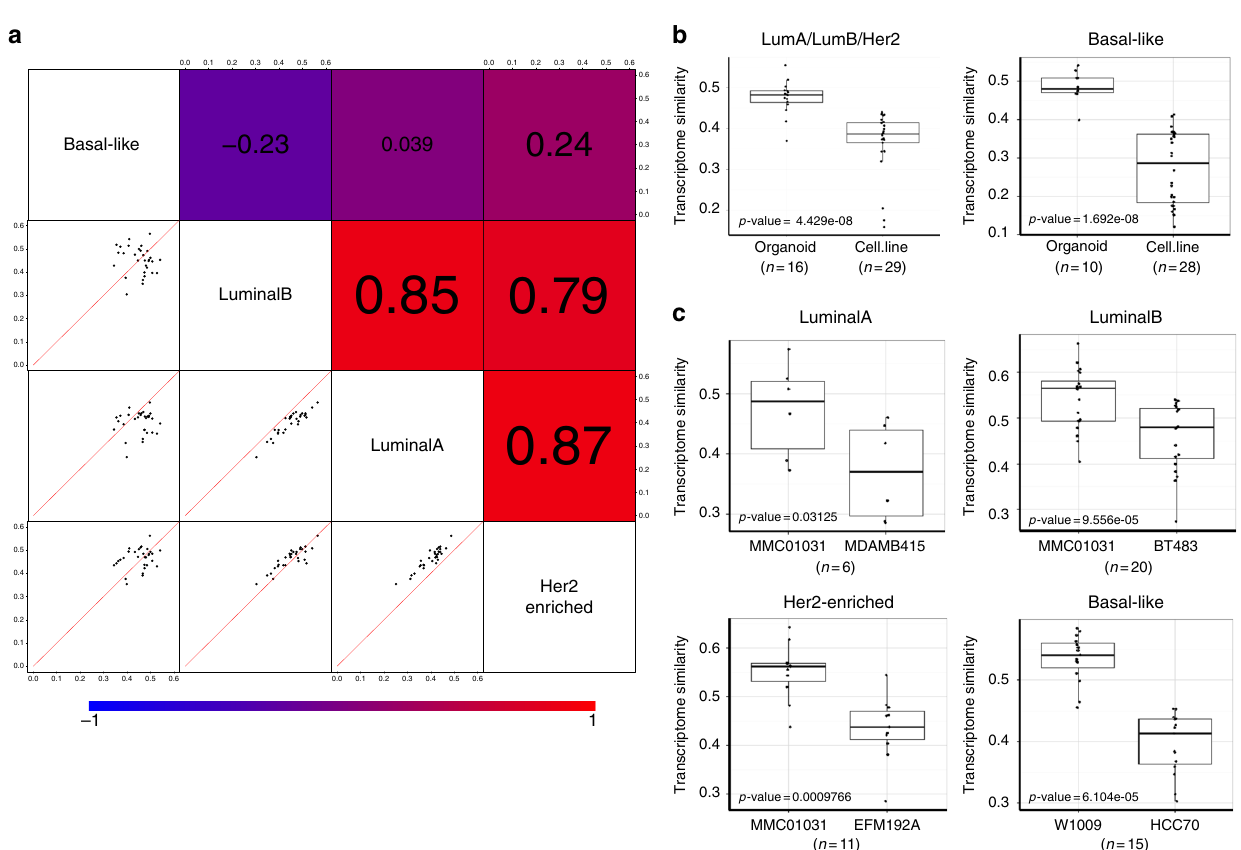
Fig. 5 Comparing CCLE breast cancer cell lines with patient-derived organoids using gene expression data. a Pair-wise comparison of subtype-speci fi c TC analysis results. In the lower-left plots, each dot is an established organoid, with the two axis representing transcriptome similarity of the organoid with MET500 breast cancer samples of the two intersecting subtypes. The upper-right shaded values are the corresponding pair-wise spearman rank correlation values of each pair. b Boxplot of transcriptome similarity (with MET500 breast cancer samples of different subtypes) of CCLE breast cancer cell lines and organoids. P -values are computed with the two-sided Wilcoxon rank-sum test. In each box, the central line represents the median value and the bounds represent the 25th and 75th percentiles (interquartile range). The whiskers encompass 1.5 times the interquartile range. c For each subtype, the most-correlated organoid has signi fi cantly higher expression correlation with MET500 breast cancer samples of that subtype than the most-correlated cell line. P -values are computed with the two-sided Wilcoxon rank-sum test. In each box, the central line represents the median value and the bounds represent the 25th and 75th percentiles (interquartile range). The whiskers encompass 1.5 times the interquartile range. Source data are provided as a